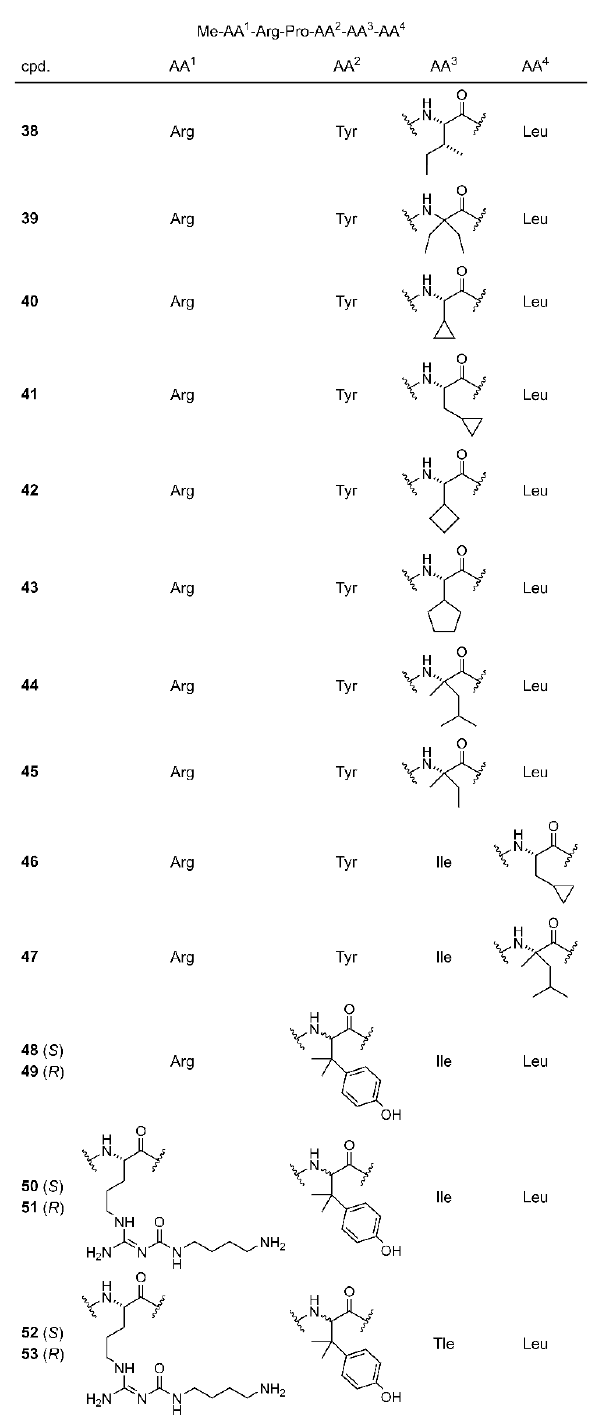
Figure 2. Structures of the C-terminally modified NT(8-13) derivatives 38 – 49 and the amino-functionalized precursor compounds 50 – 53 , representing derivatives of 48 and 49 .